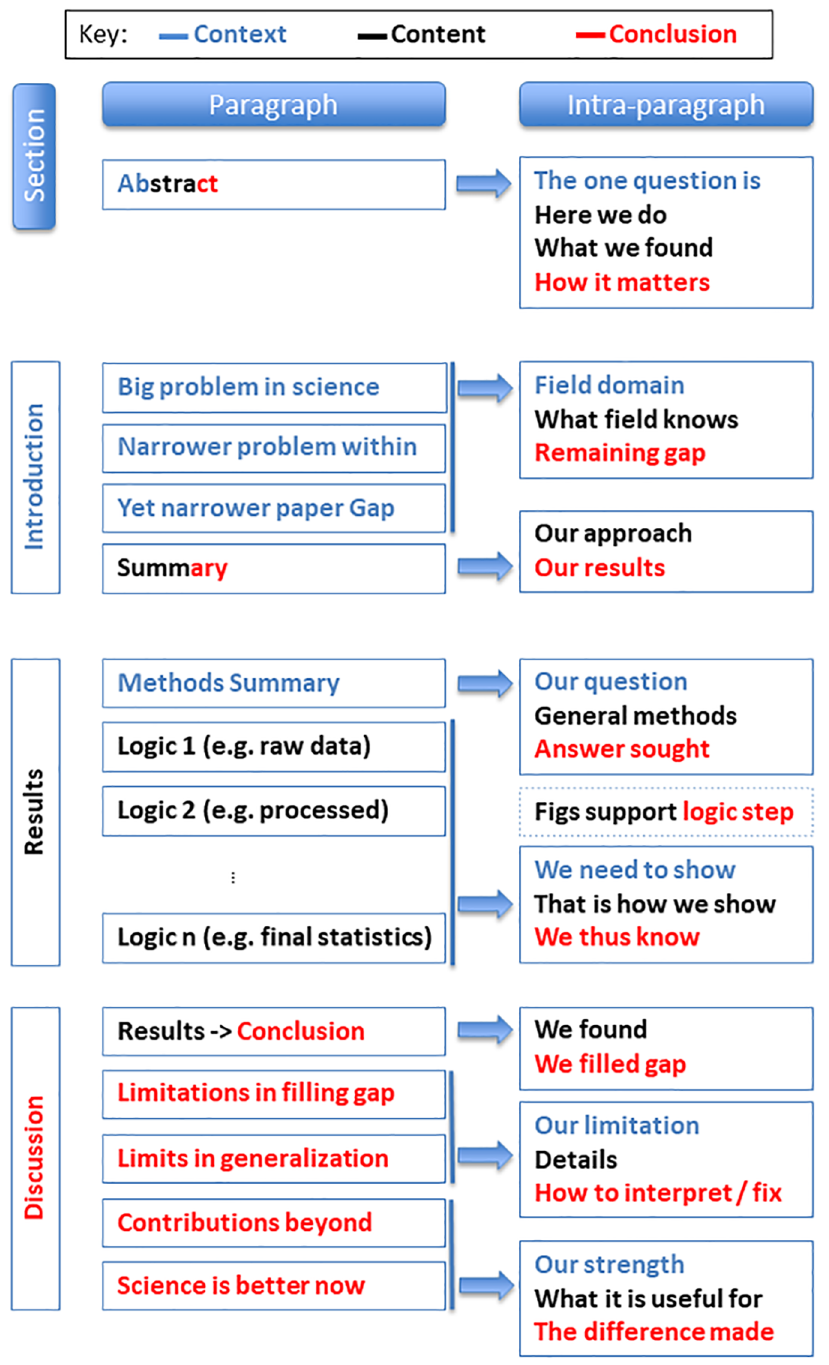
Fig 1. Summary of a paper’s structural elements at three spatial scales: Acrosssections, across paragraphs, and within paragraphs. Note that the abstract is specialin that it containsall three elements (Context, Content, and Conclusion), thus comprisingall three